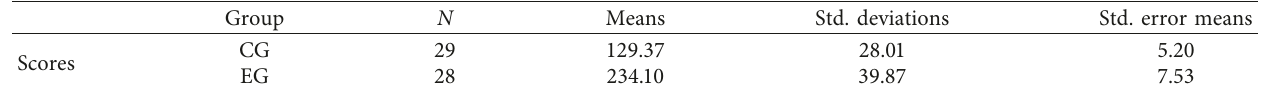
Table 7: Descriptive statistics (motivation post-test of both